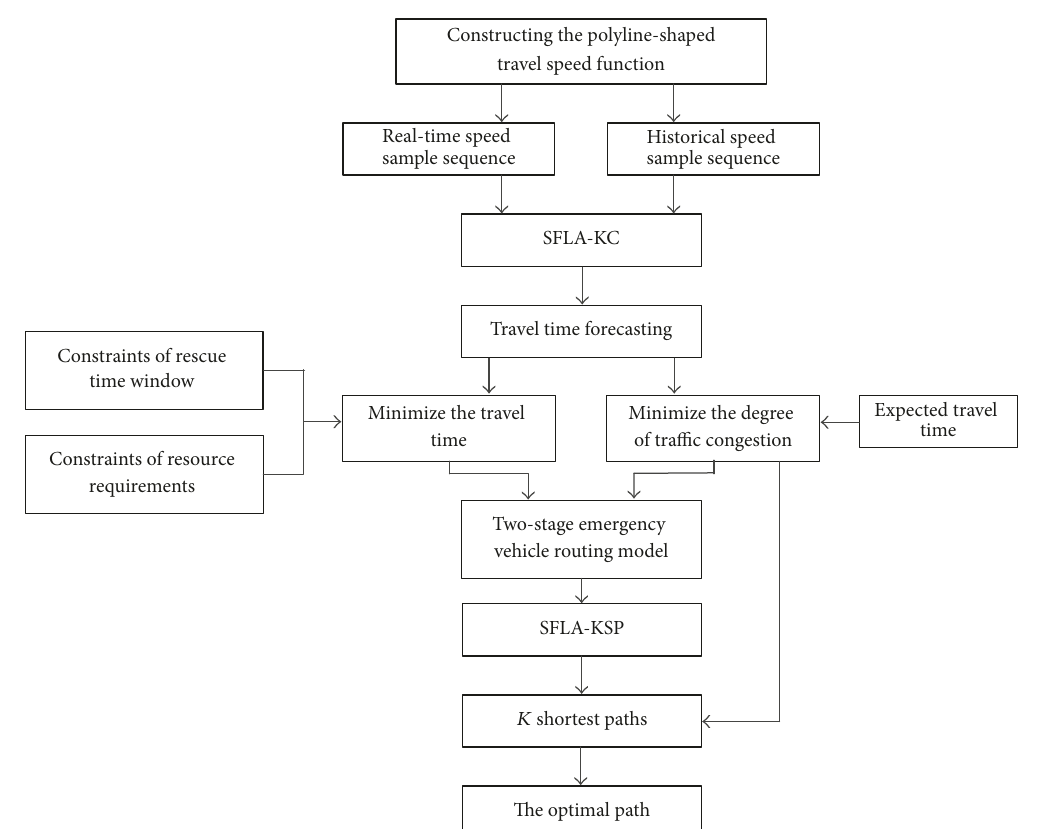
Figure 1: Research content and